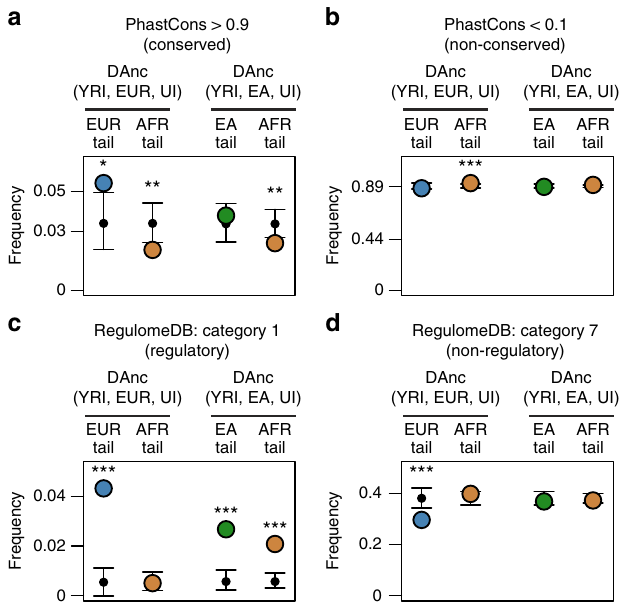
Figure 3 | Conservation and putatively regulatory role of genic alleles in DAnc tails. Conservation was measured with phastCons 31 , with ( a ) phastCons 4 0.9 representing strongly conserved sites and ( b ) phastCons o 0.1 non-conserved sites. Observed frequencies of genic alleles with different levels of phylogenetic conservation are shown for the DAnc(YRI, Europe, UI) tails and the DAnc(YRI, East Asia, UI) tails using a coloured dot (blue for European, green for East Asian, orange for African). On the basis of resampling from the entire distribution the mean expectation is shown as a black dot and the 95% confidence interval as black lines. Asterisks indicate significant differences between observations and expectation (* P o 0.05, ** P o 0.01 and *** P o 0.001). c and d show the same analysis for putative regulatory function according to regulomeDB 32 , with ( c ) regulomeDB category 1 representing likely regulatory sites and ( d ) category 7 representing sites with no evidence of a regulatory role. AFR, African (YRI); EA, East Asia; EUR, Europe; UI, Ust 0